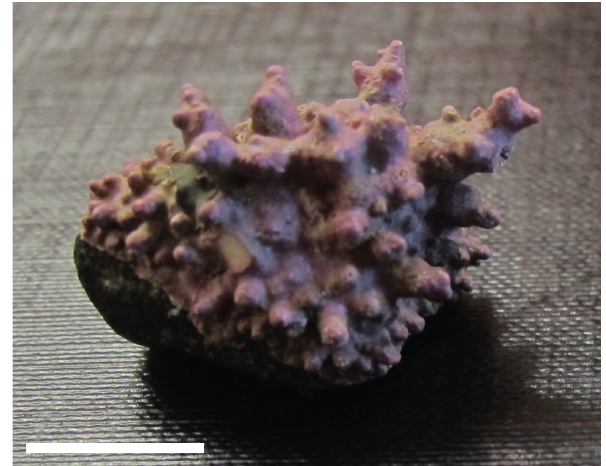
Figure 1. A Lithothamnion glaciale specimen in crustose form from Loch Creran, Oban, Scotland; Scale =